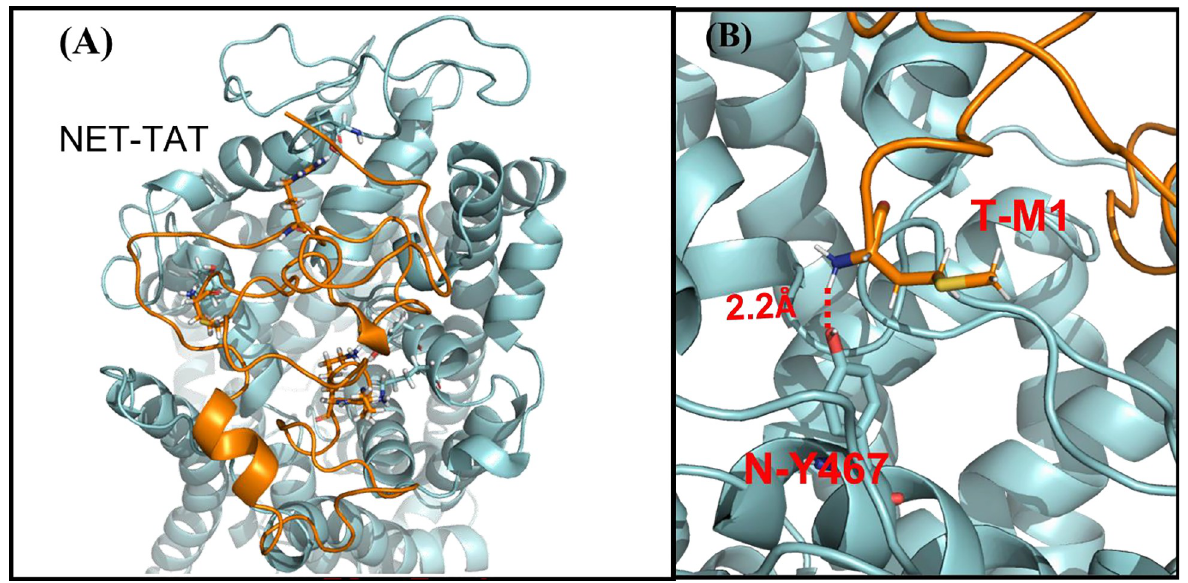
Fig 1. Overview of hNET-Tat complex structure. (A) hNET and Tat are showed in cyan and gold surface style, respectively. (B) Local view of the favorable hydrogen bond between the positively charged N-terminal amino group of residue M1 in Tat and the hydroxyl group of residue Y467 in hNET with labeled